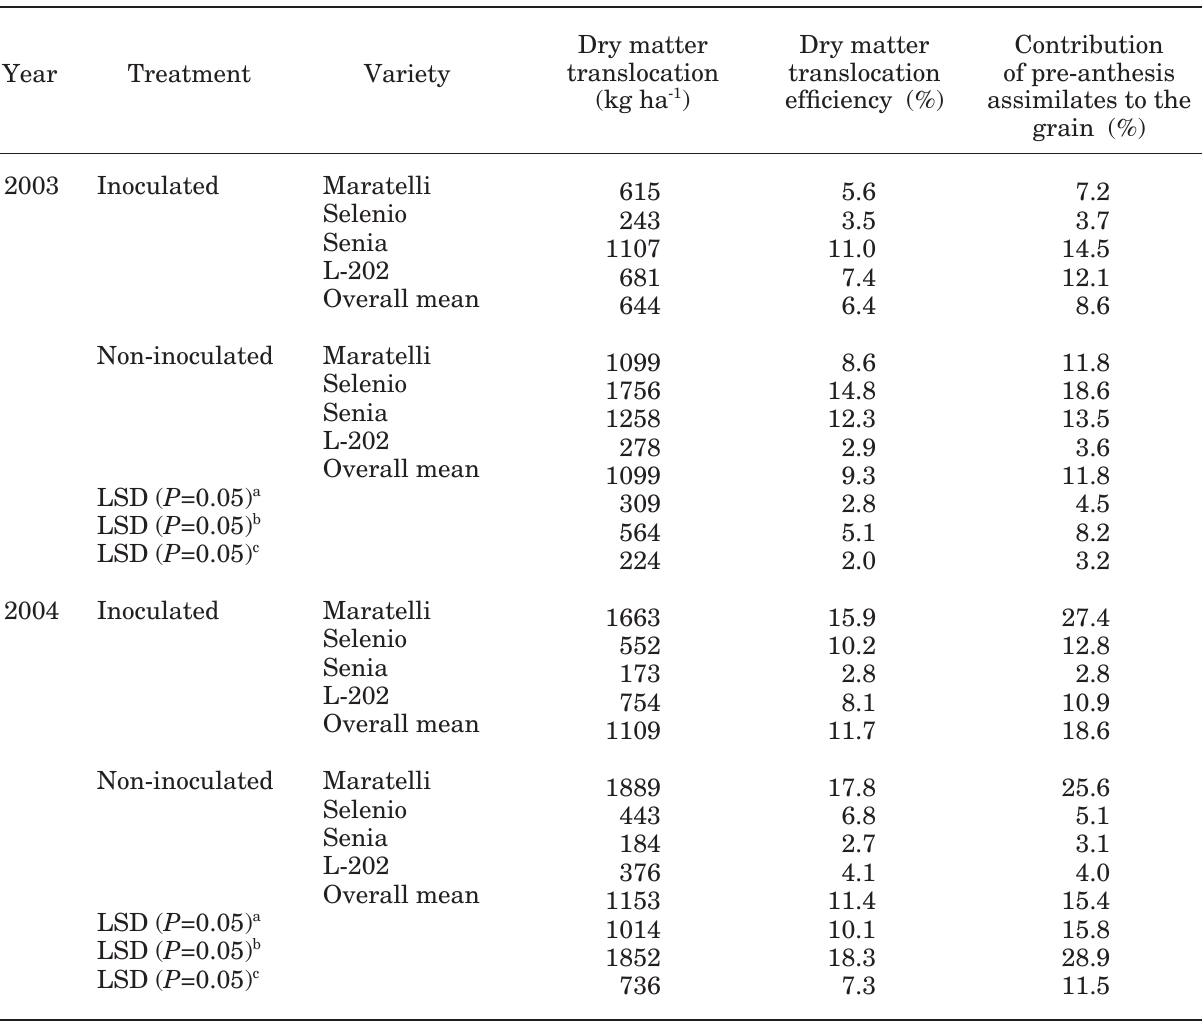
Table 3. Dry matter translocation, dry matter translocation efficiency and contribution of pre-anthesis assimilates to the grain of four rice varieties inoculated and non-inoculated with Magnaporthe grisea in field experiments conducted in 2003 and